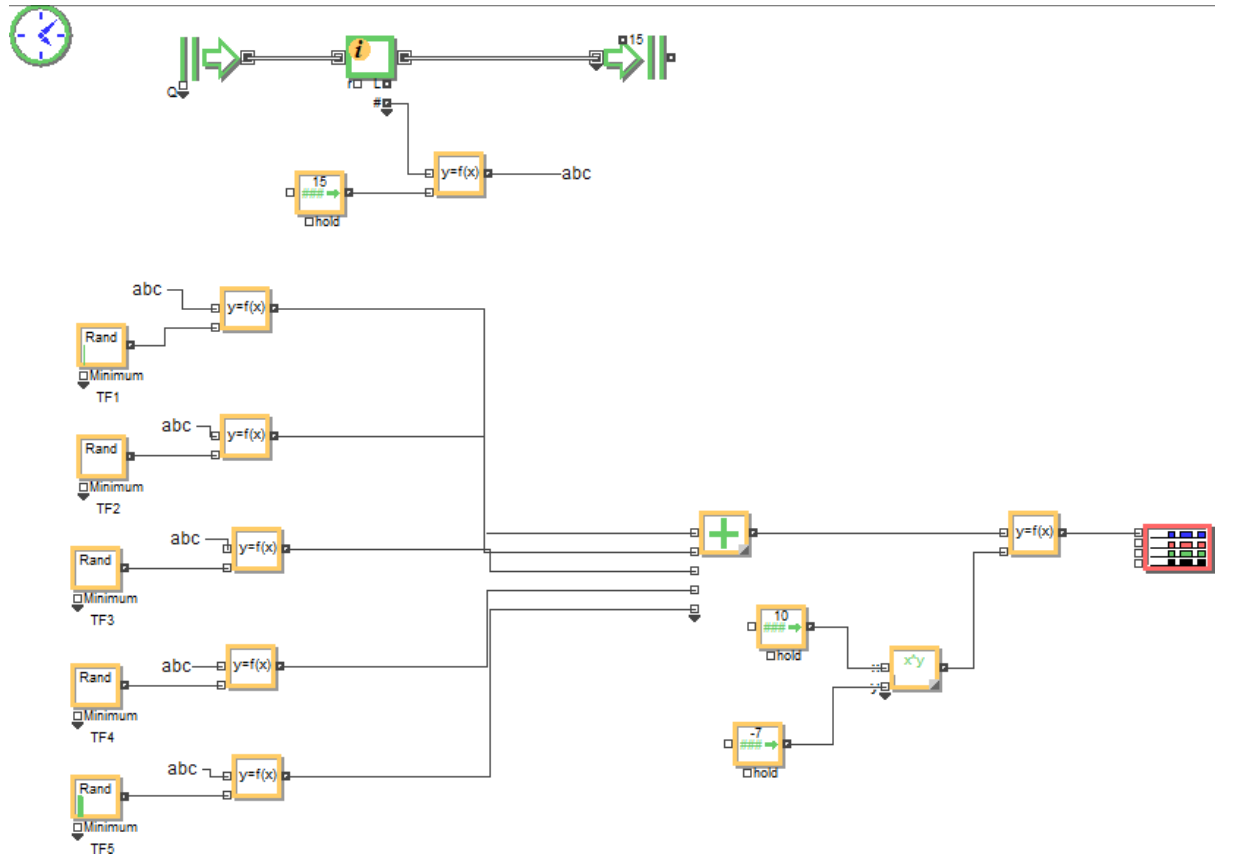
Figure 1: The model of simulation by the program ExtendSim8